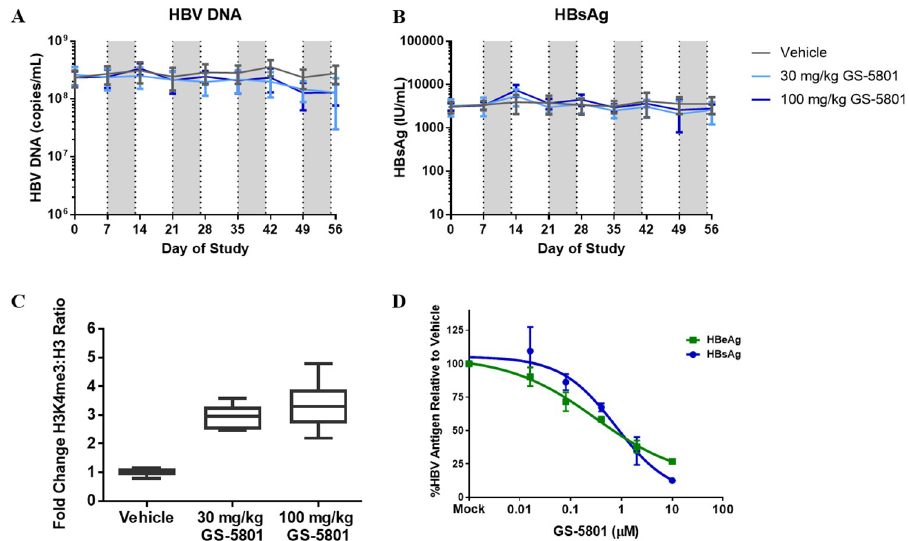
Fig 8. GS-5801 does not reduce HBV DNA or HBsAg levels in a humanized mouse model of HBV infection. uPA-SCID mice with humanized livers were infected with HBV GTC virus and dosed p.o. with 30 or 100 mg/kg of GS- 5801once daily for seven days in a one week on one week off dosing regimen. Every seven days, levels of HBV DNA (A) and HBsAg (B) were measured. Data is plotted as the average of n = 6–8 mice/timepoint/dose group, error bars represent the standard deviation. Shaded grey areas indicate the dosing periods. (C) At study endpoint, Day 56, levels of H3K4me3 and H3 were measured in liver tissue via ELISA to assess GS-5801 pharmacodynamics. Data is shown as the average fold change in H3K4me3:H3 ratio in mice (n = 6–8 per dose group) treated with 30 mg/kg or 100 mg/kg of GS-5801 and normalized to vehicle-treated animals; error bars represent the standard deviation. (D) The antiviral activity of GS-5801 was assessed in vitro with the same hepatocytes and GTC virus used in the in vivo HBV efficacy model. Hepatocytes were plated and infected with HBV prior to GS-5801 compound treatment. At Day 21, antiviral activity was assessed by measuring extracellular levels of HBsAg and HBeAg. Data is plotted as the average of biological duplicate samples; error bars represent the standard